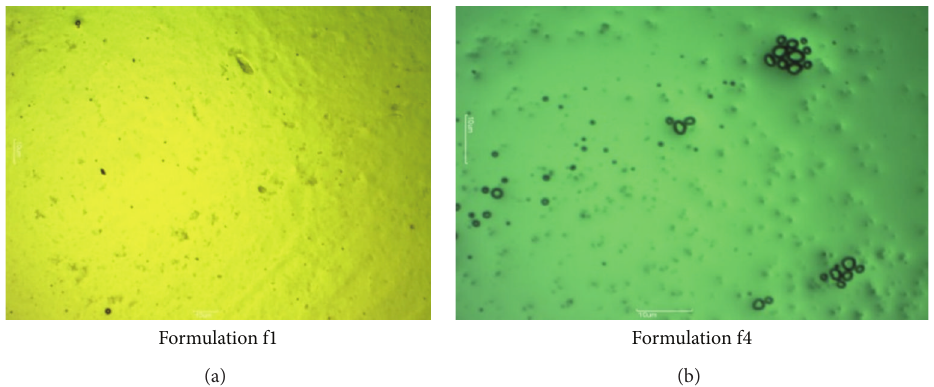
Figure 9: Optical microscopic images of formulation at 4x magnification.